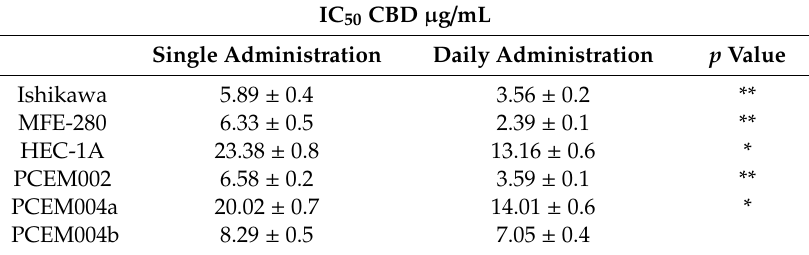
Figure 8. CBD induced cytotoxicity in EC cell lines. Cell viability was determined by MTT assay. Ishikawa, MFE-280, HEC-1a, PCEM002, PCEM004a and PCEM004b cells were treated for 72 h with di ff erent concentrations of CBD (up to 15.72 µ g / mL). Data shown are expressed as mean ± SD of three separate experiments. * p < 0.05 treated vs. vehicle, # p < 0.05 daily vs. single administration. Table 2. CBD IC 50 values in EC cell lines expressed as mean ± SD of three separate